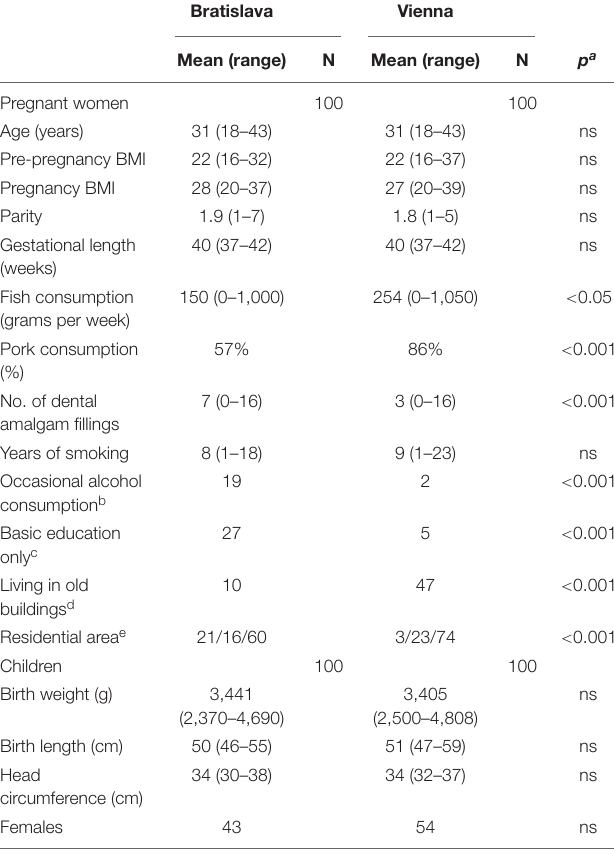
TABLE 1 | Characteristics of the study groups in Bratislava and Vienna.